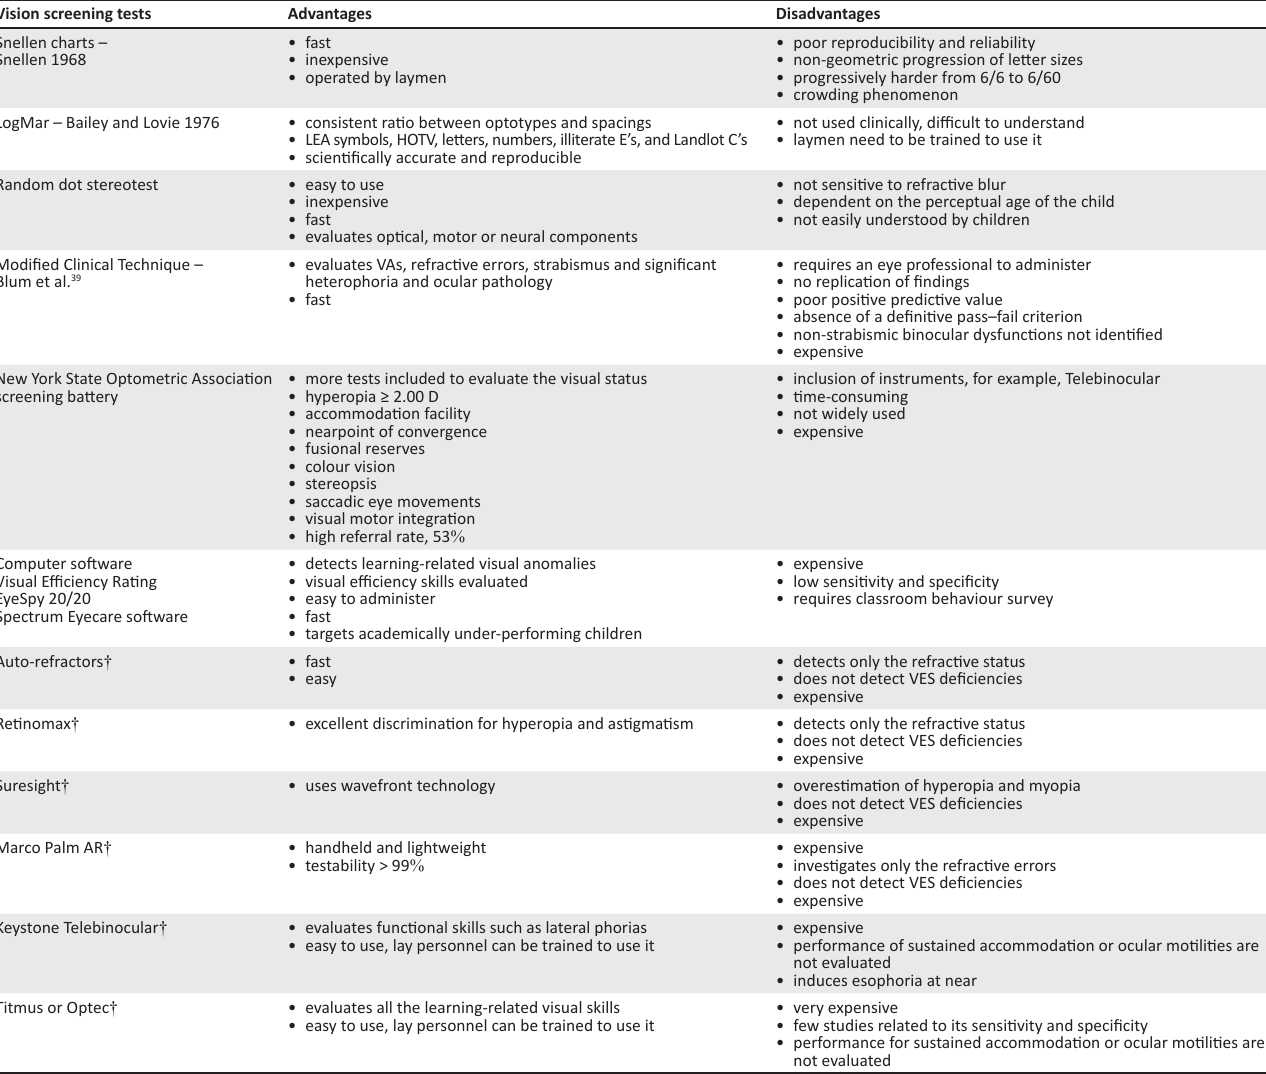
TABLE 3: Vision screening techniques: A summary of the advantages and